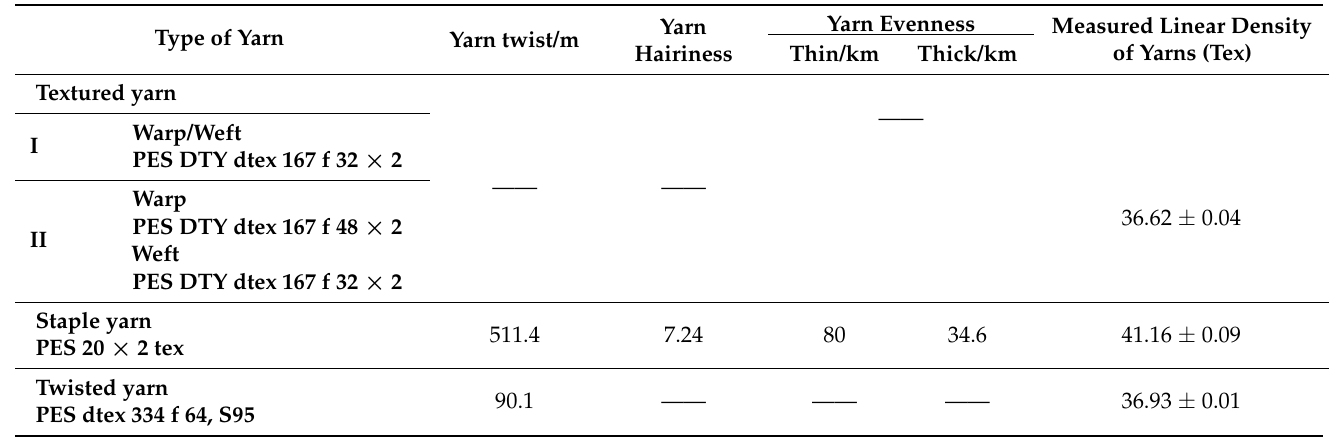
Table 2. Physical properties of three different yarn types.